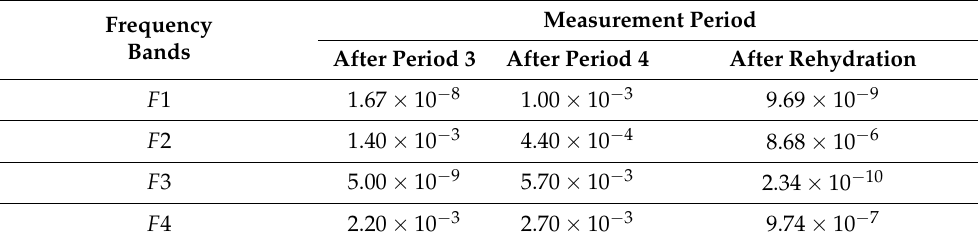
Table 3. The p -values of two-sample t-tests for selection of frequency bands having discriminatory power in human participant